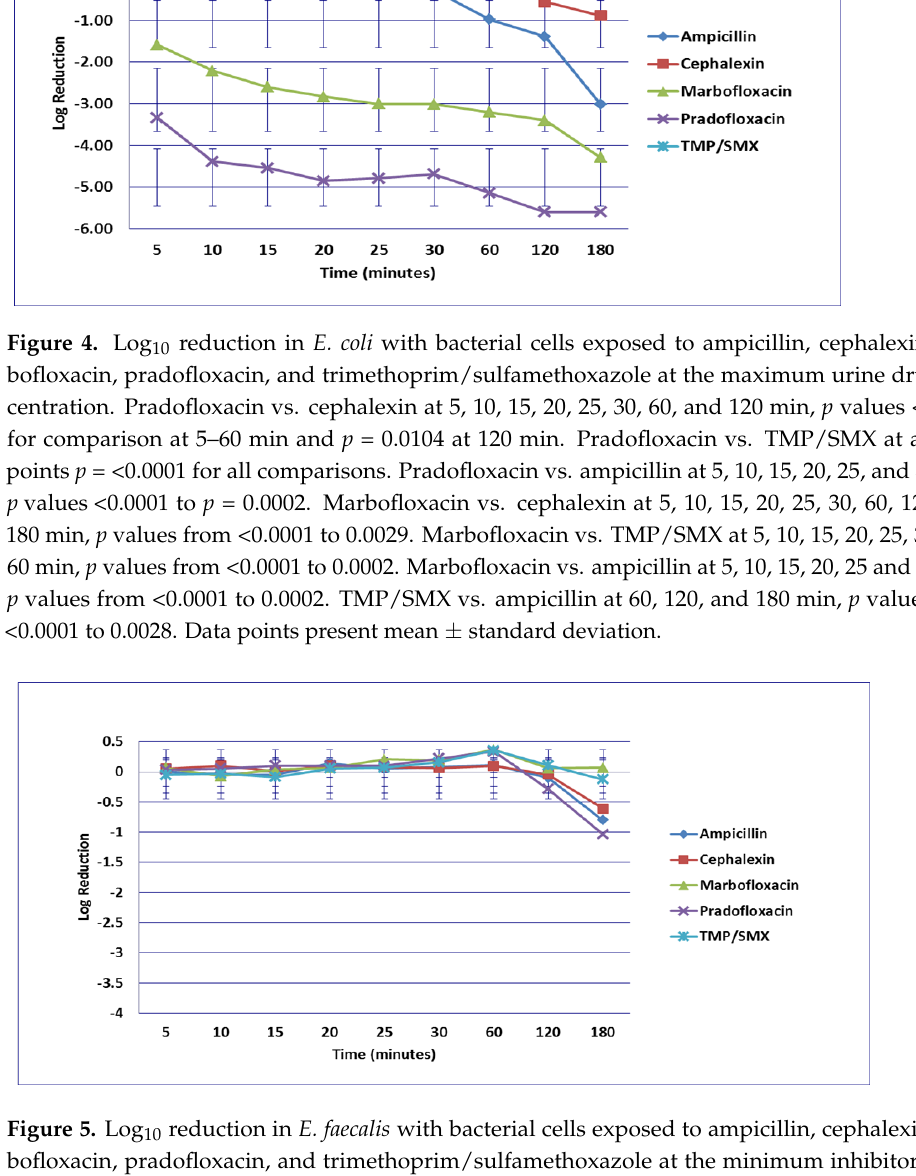
Figure 6. Log 10 reduction in E. faecalis with bacterial cells exposed to ampicillin, marbofloxacin, and pradofloxacin at the mutant prevention drug concentration. Data points present mean ± standard deviation. Figure 7. Log 10 reduction in E. faecalis with bacterial cells exposed to ampicillin, cephalexin, mar- bofloxacin, pradofloxacin, and trimethoprim/sulfamethoxazole at the maximum serum drug con- centration. Pradofloxacin vs. cephalexin at 120 and 180 min, p values <0.0001 for both comparisons. Marbofloxacin, TMP/SMX, and ampicillin versus cephalexin at 120 and 180 min, p value <0.0001 for all comparisons. Data points present mean ± standard deviation.